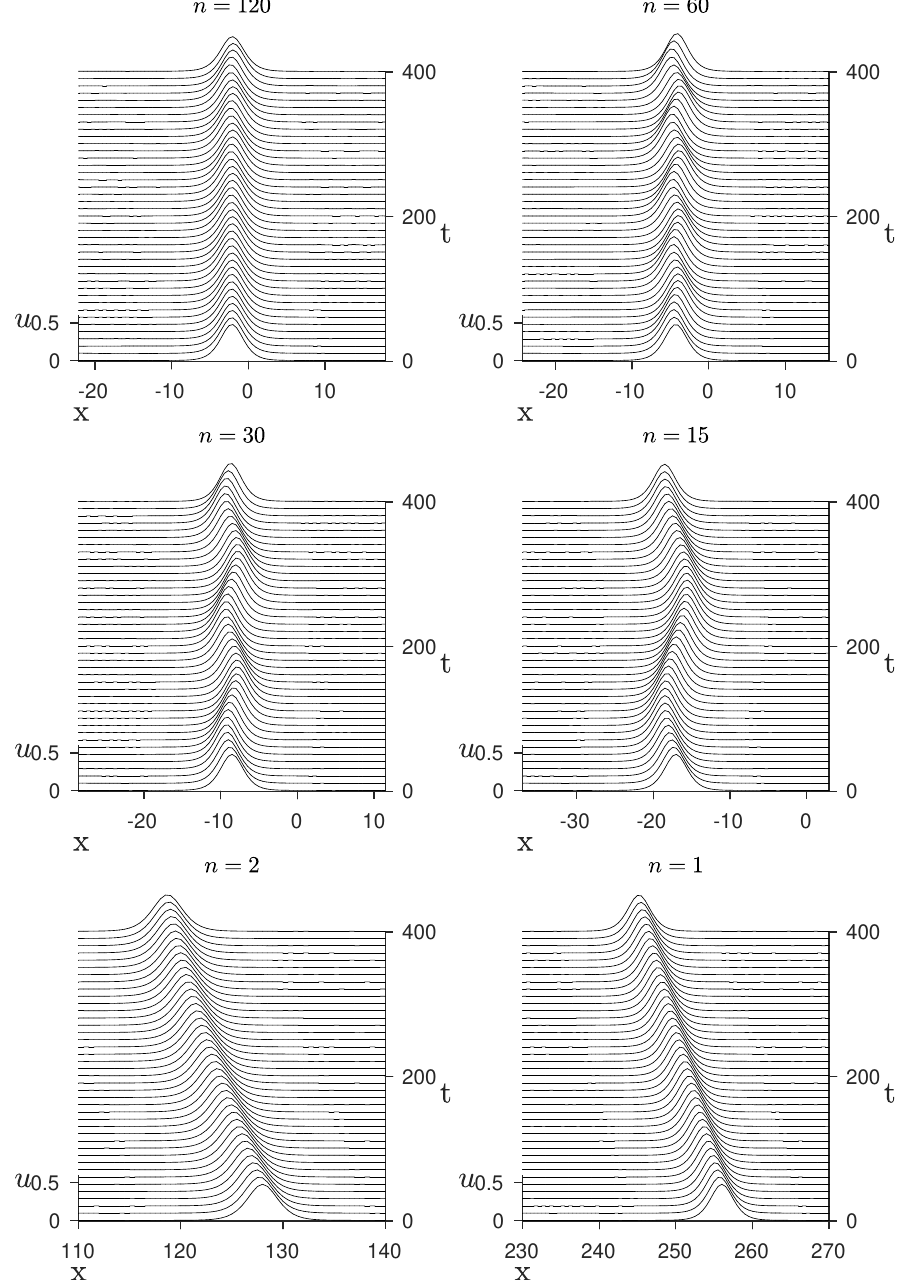
Figure 8. Solitary wave solutions over the periodic forcing. Parameters: ∆ = − 2 a , x 0 = π /2 q , A =